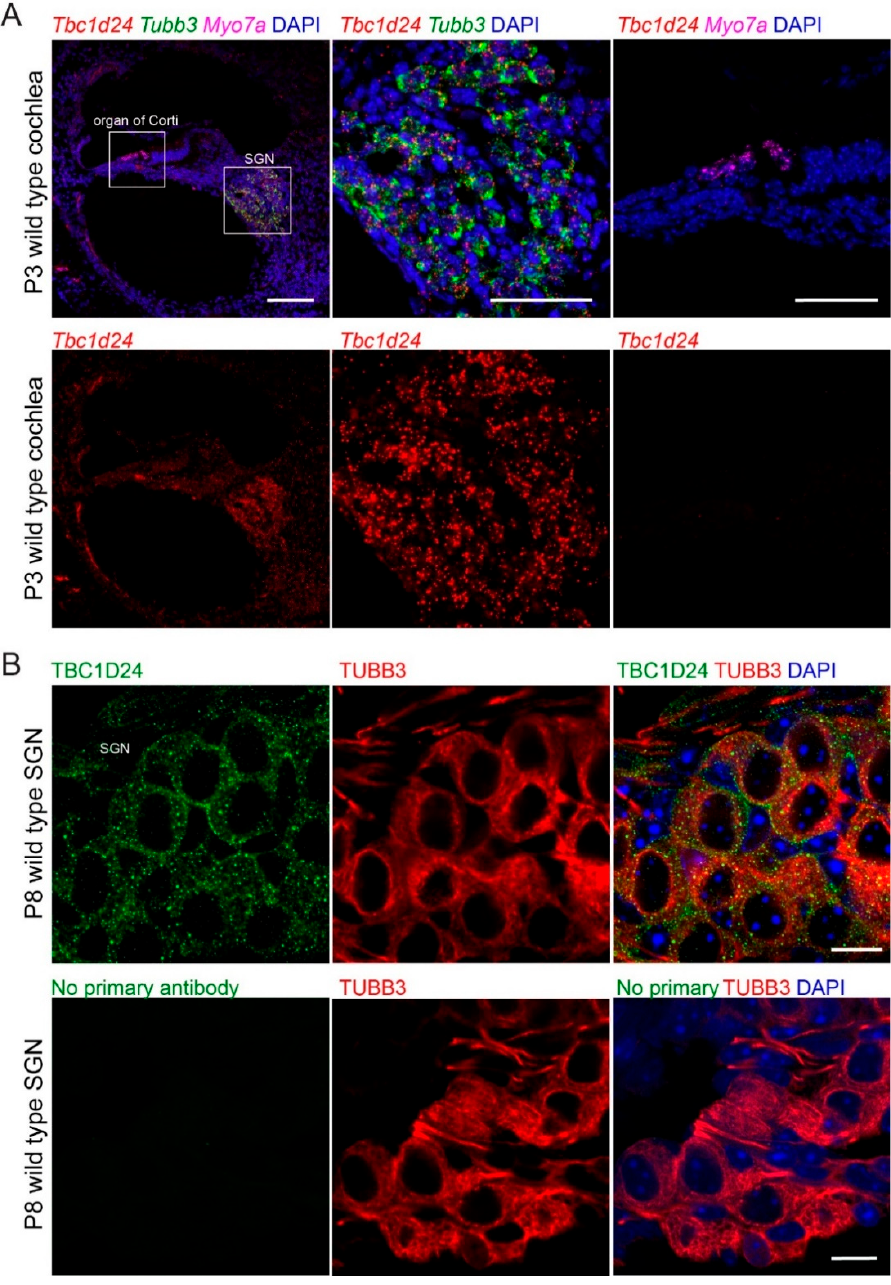
Figure 2. Expressions of mouse Tbc1d24 mRNA and TBC1D24 protein in spiral ganglion neurons (SGN). ( A ) In situ hybridization using an RNAscope probe in wild type mouse cochlea at P3. Tbc1d24 mRNA (red, probe-Mm-Tbc1d24) is present in SGN. Expression of Tbc1d24 mRNA was not detected in the organ of Corti. Hair cells and SGN were labeled using RNAscope probes that recognize Myo7a (magenta, Probe-Mm-Myo7a-C2), and Tubb3 (green, Probe-Mm-Tubb3-C4), respectively. Middle panels are enlarged images of the SGN. Right panels are enlarged images of the organ of Corti. Scale bars are 100 µm (left panel) and 50 µm (middle and right panels). ( B ) Localization of TBC1D24 in wild type mouse SGN. TBC1D24 (green) colocalizes with TUBB3 (red), a marker for the cell body of spiral ganglion neurons, in P8 mouse cochlea. Scale bars are 10 µm.